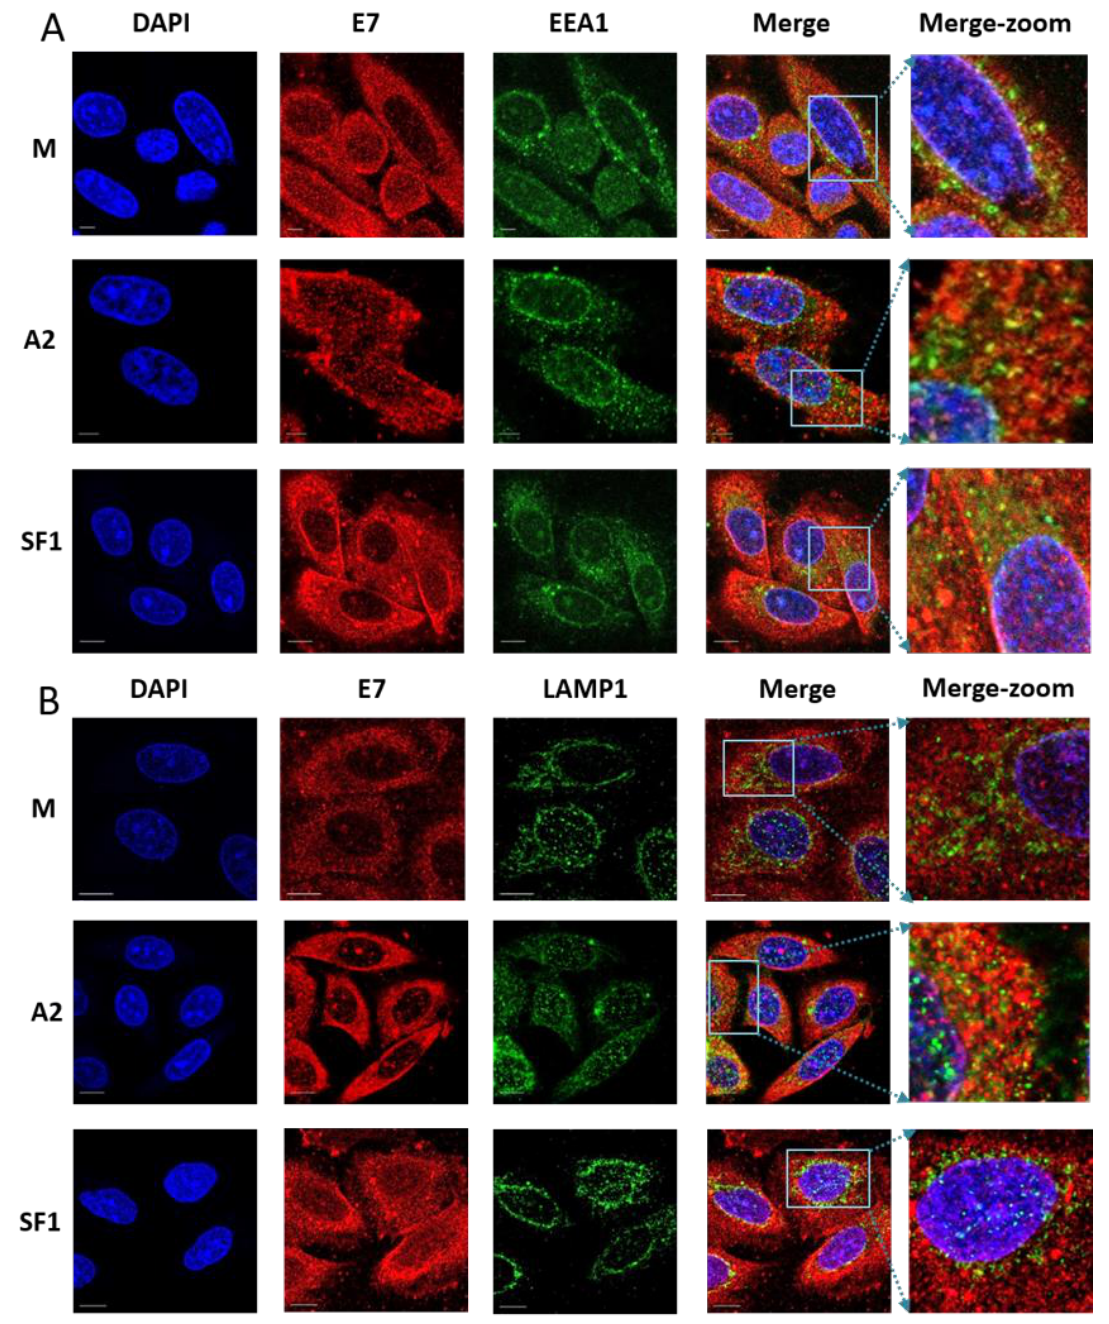
Figure 5. Cont Figure 5. Cont.